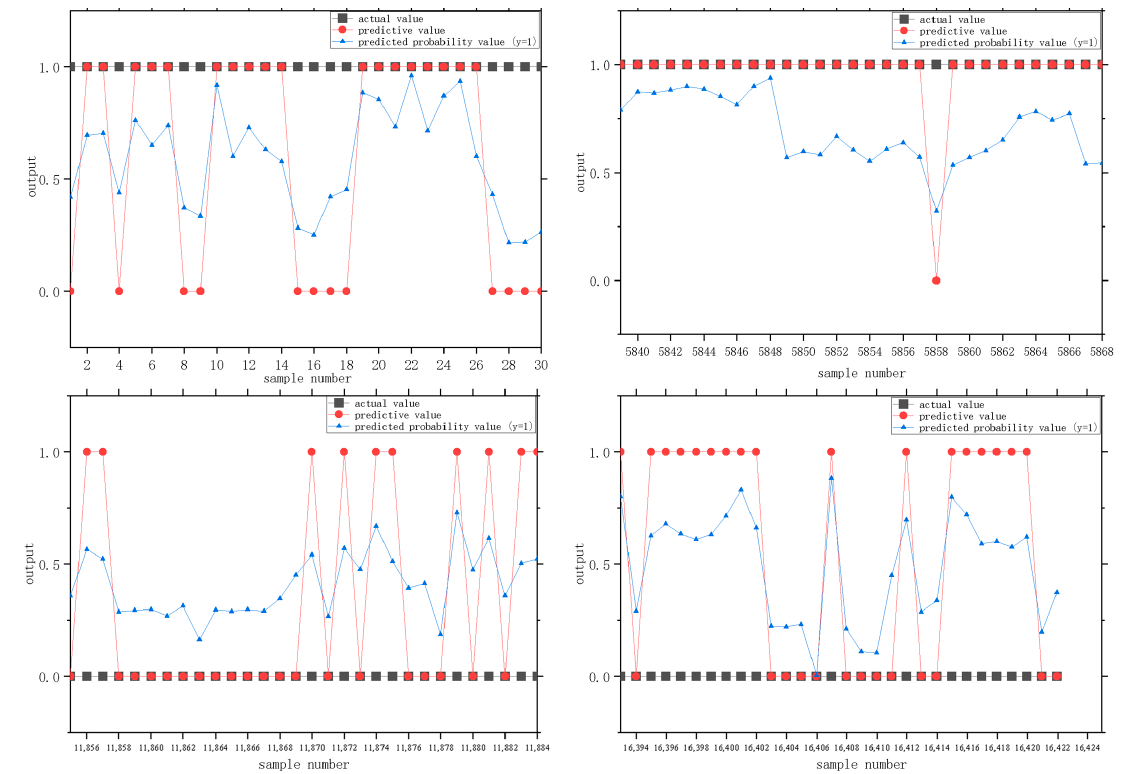
Figure 5. Comparison charts of the predictive and actual values of the RBFNN (part of the